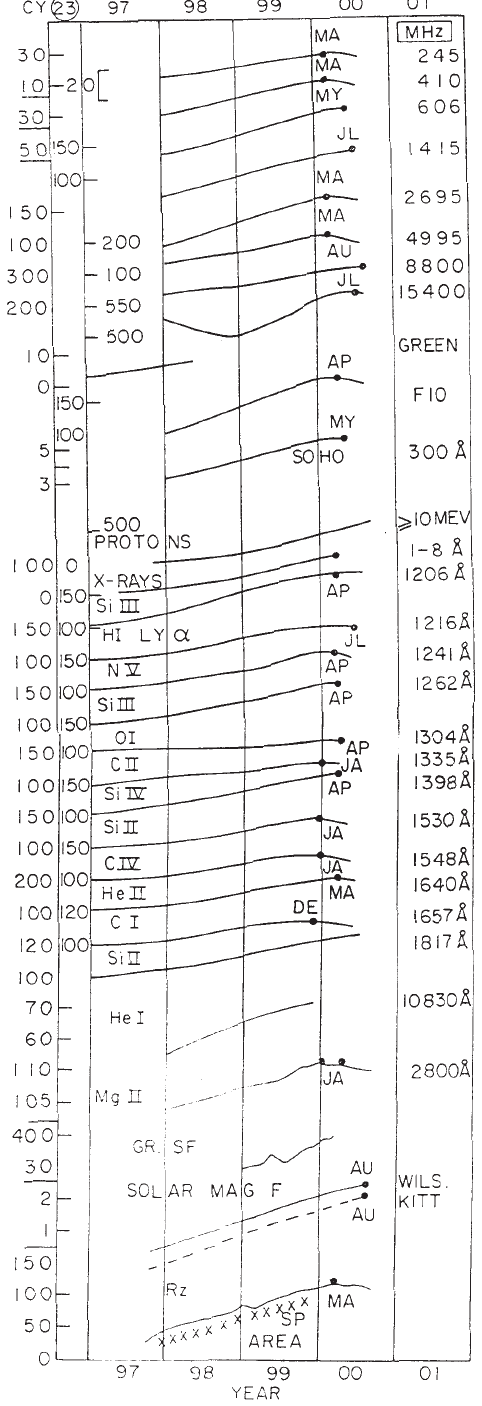
Fig. 6. Plots of smoothed values of the various solar indices in years near sunspot maximum of the present cycle 23, 1997 onwards. The full dots indicate